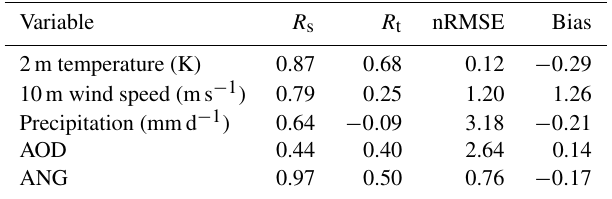
Table 1. Statistical scores (correlation, RMSE and bias) for the 2m temperature, 10m wind speed, precipitation rate, aerosol optical depth (AOD) and Ångström exponent (ANG). Calculations are per- formed for the whole month of July 2016 and are based on hourly data. The bias is computed as model minus observation. Variable R s R t nRMSE